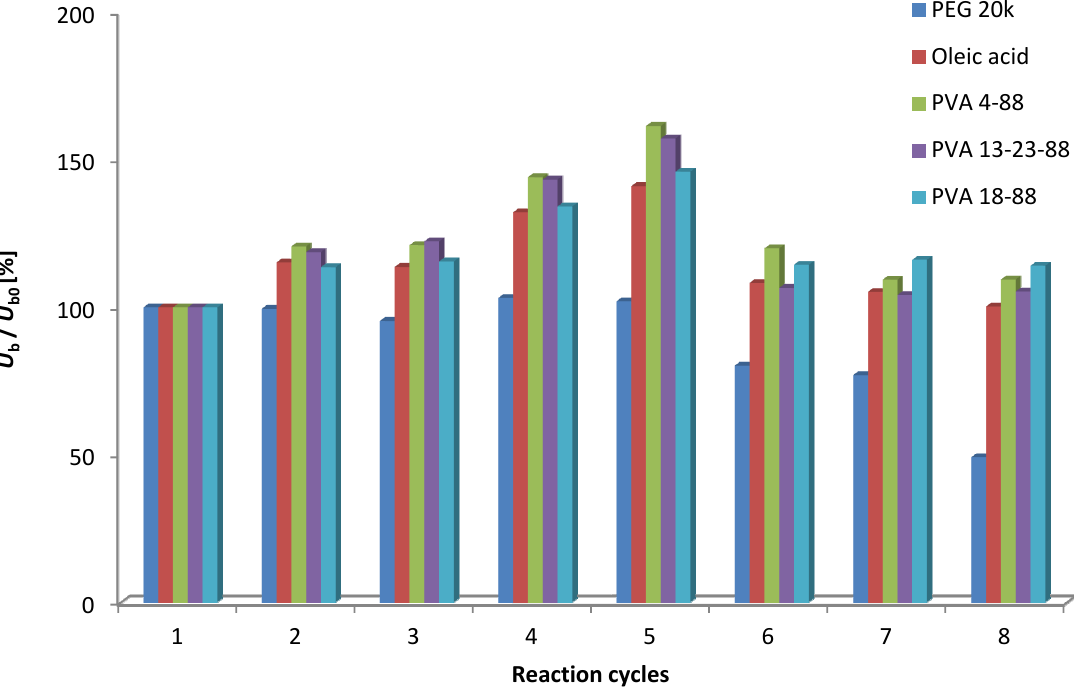
Figure 3. Recycling of the adsorbed Bc L from repeated kinetic resolutions of rac -1a